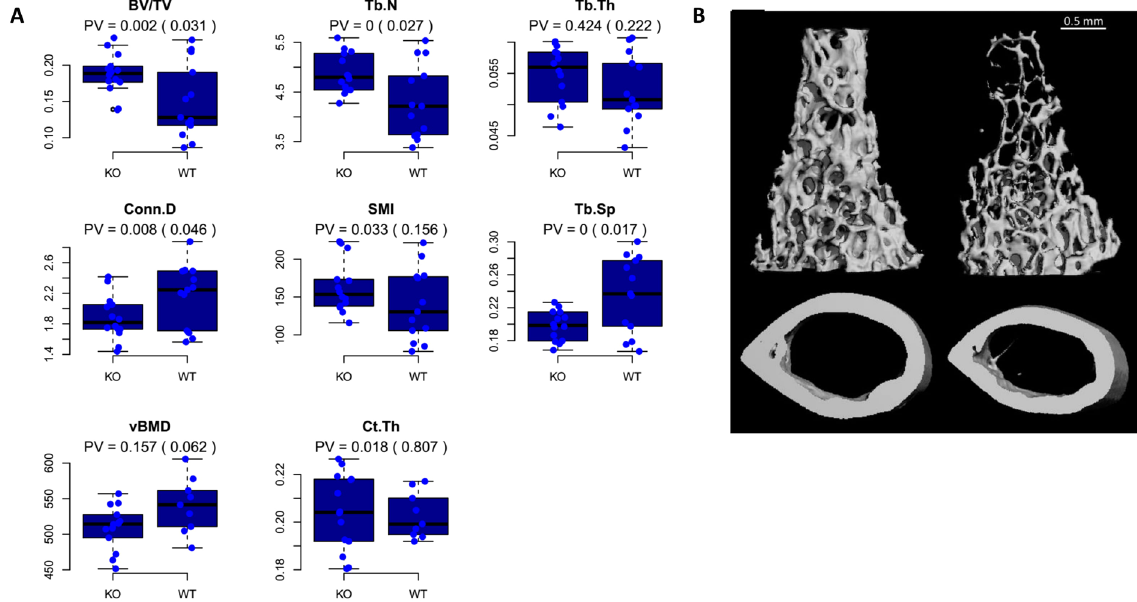
Figure 6. High trabecular bone mass in Rhbdf2 knockout mice. µ CT analysis in the femora of 11-week-old KO (left) versus WT (right) male mice. ( A ) Quantitative morphometric parameters presented as box-and-whisker plots, in which the horizontal black line is the median; whisker limits are minimum and maximum values; and the blue bar is the inter-quantile range. PV, P value KO vs WT. ( B ) Representative trabecular (top) and cortical (bottom) bone 3D reconstructions for Rhbdf2 knockout (left) and wild-type (right)